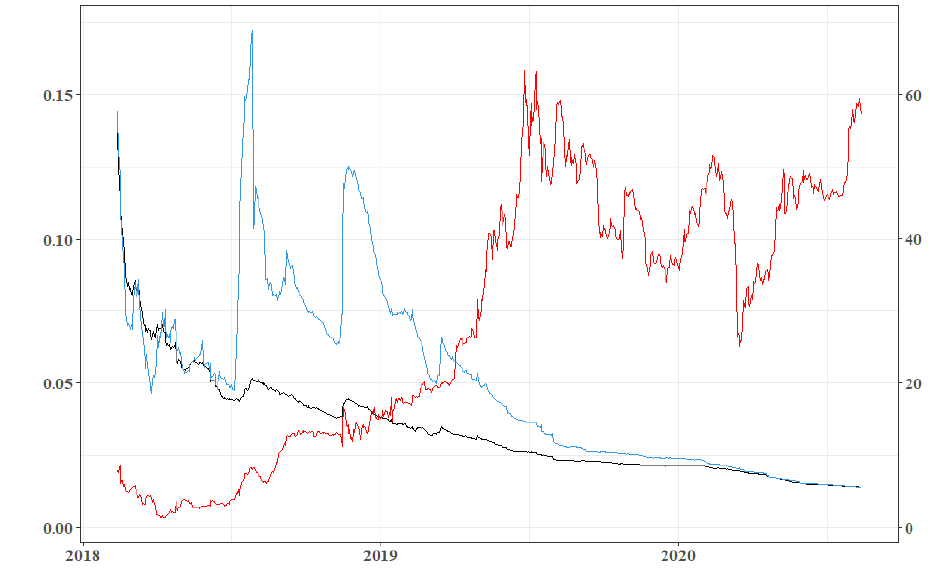
Figure 3. Evolution of LN’s normalized efficiency. The plot exhibits the evolution of LN’s global normalized efficiency (in light blue), its density (in black) multiplied by 10, and the median capacity installed on its channels (in red). Both density and efficiency can assume values between 0 and 1. The y-axis on the left is related to the density and efficiency measures, while the one on the right is related to the median capacity expressed in